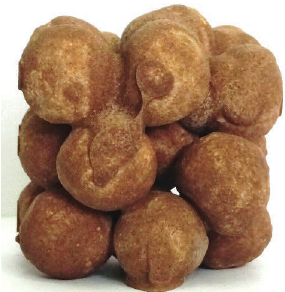
Fig. 11. Coarse-pored granular composite.